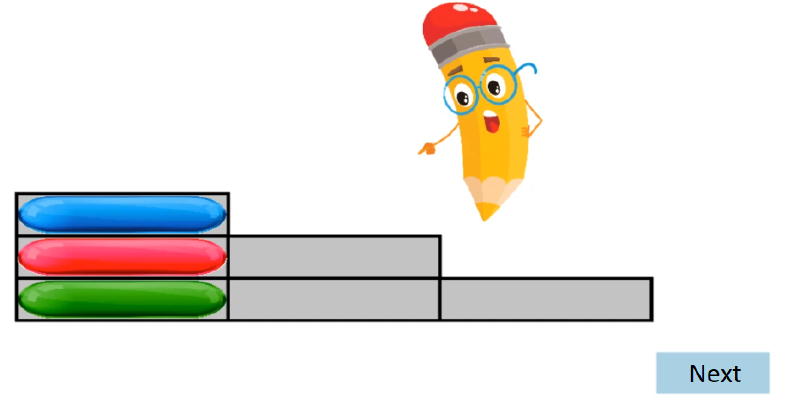
Figure 2. Tutorial with animation during the Familiarization